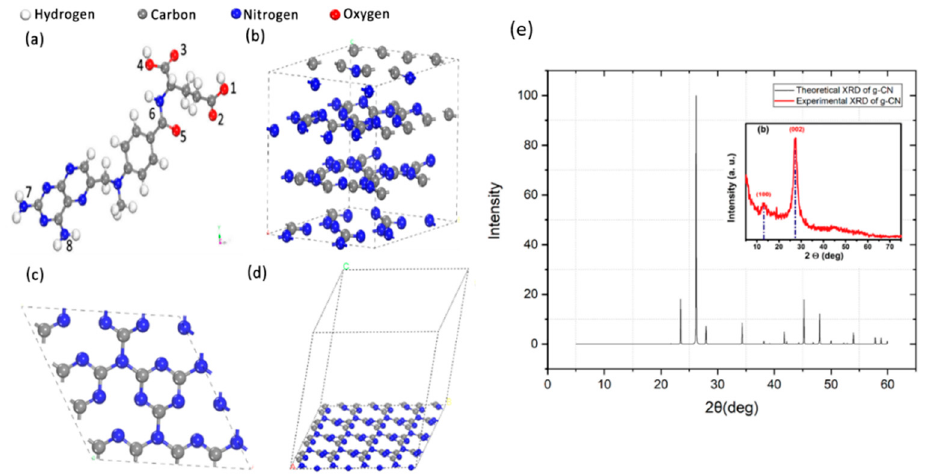
Figure 2. Structure of ( a ) MTX with identical positions of (1, 4), (2, 3), and (7, 8), ( b ) g-CN (Bulk), ( c ) Facet (002) cleaved from the bulk g-CN, ( d ) surface (002) with vacuum slap, and ( e ) theoretical versus experimental XRD spectra of g-CN.